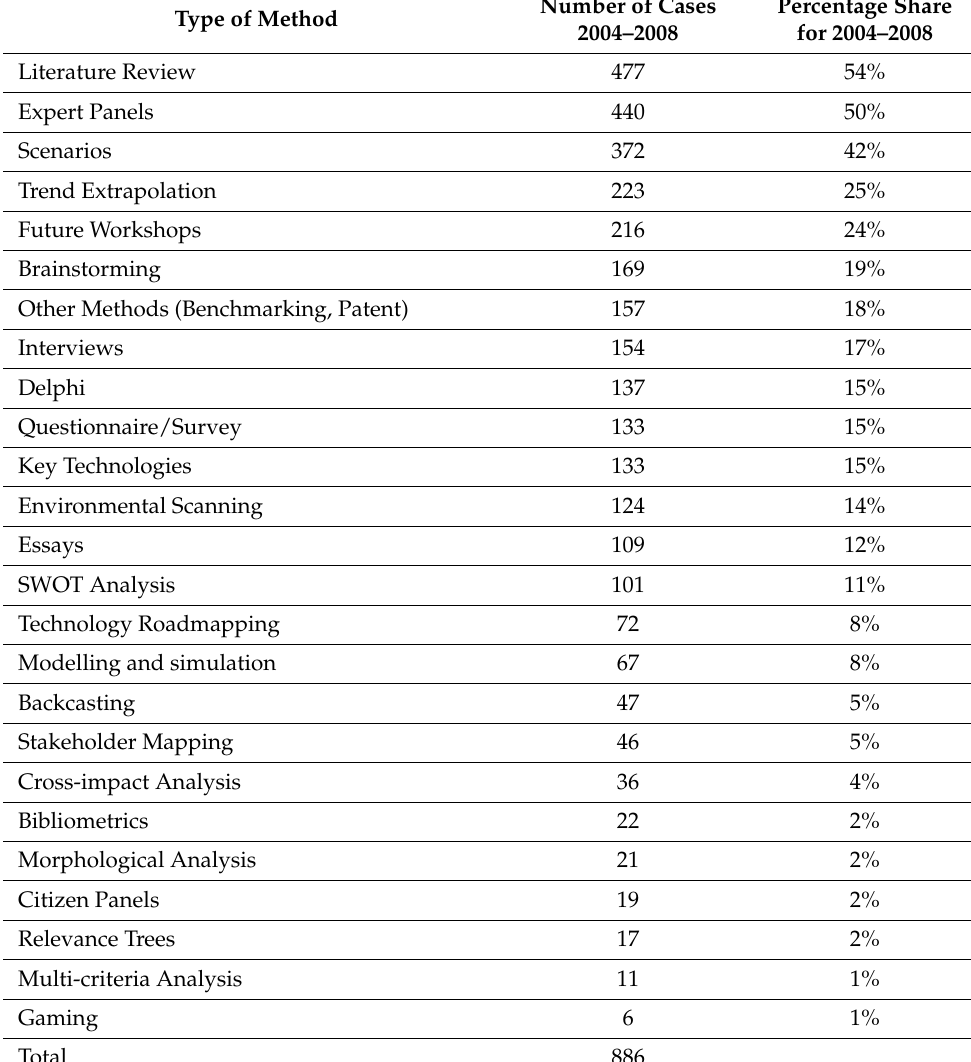
Table 3. Frequency of use of methods in foresight projects. Source: [42] (p.